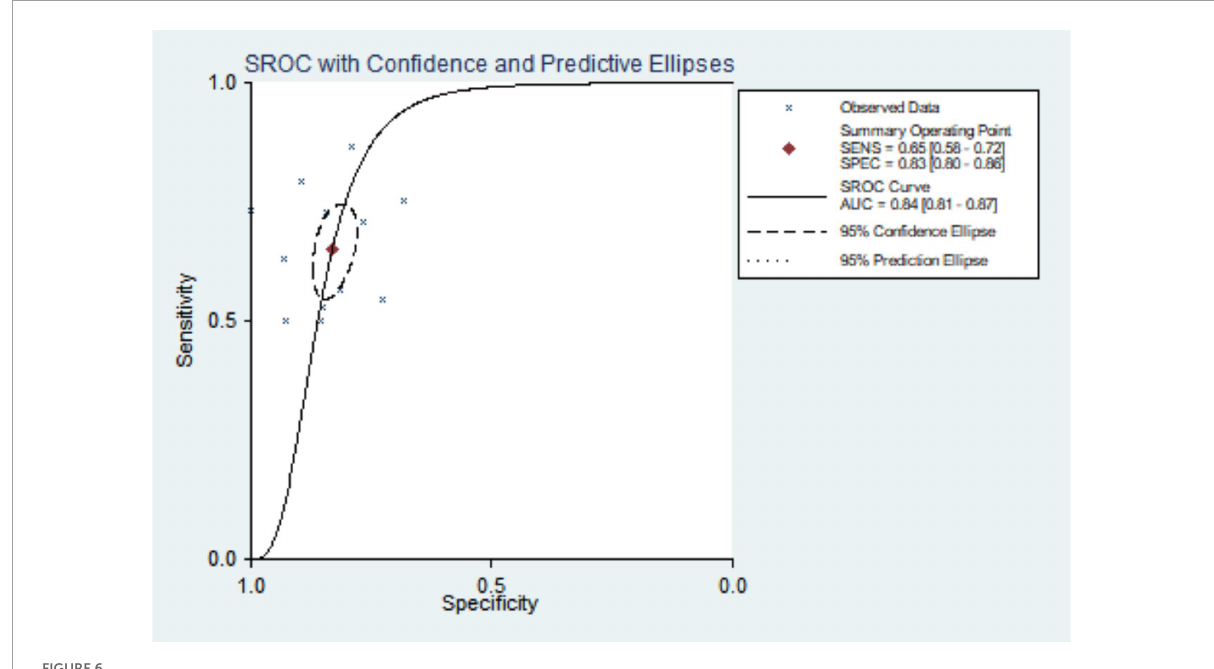
FIGURE6 Summary receiver operating characteristic curve for CT diagnosis of pulmonary hypertension.